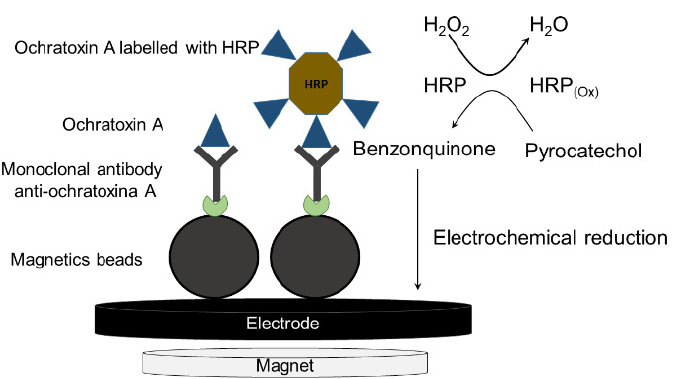
Figure 2. Schematic representation of electrochemical immunosensor for OTA determination in red wine samples.